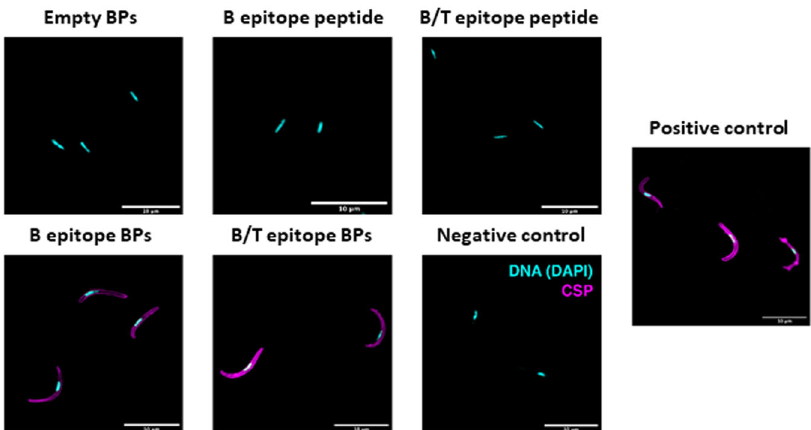
Fig. 5 Binding of antibodies from vaccinated sheep to P. falciparum NF54 sporozoites. Sporozoites labelled with antibodies puri fi ed from sheep injected with the different vaccines. Antibodies from sheep vaccinated with the soluble B- and B/T-cell epitope peptides and the empty BPs did not label the sporozoite surface like the monoclonal anti-NANP3 antibody (CSP; clone 2A10) that served as positive control (purple). Antibodies from sheep vaccinated with the B- and B/T-cell epitope-coated BPs labelled the sporozoite surface (purple). Empty BPs and only the anti-sheep antibody (negative controls) served as control and did not surface label sporozoites. DNA was visualised with DAPI (magenta). Scale bars, 10 µm.